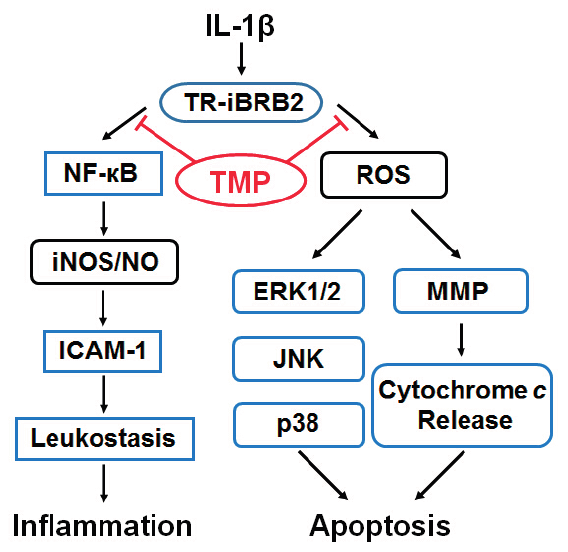
Figure 8. The proposed molecular mechanisms underpinning the protective effect of TMP on nitrosative and oxidative stress induced by IL-1 β in retinal endothelial TR-iBRB2 cells. ROS: reactive oxygen species; iNOS: inducible nitric oxide synthase; NO: nitric oxide; MMP: mitochondrial membrane